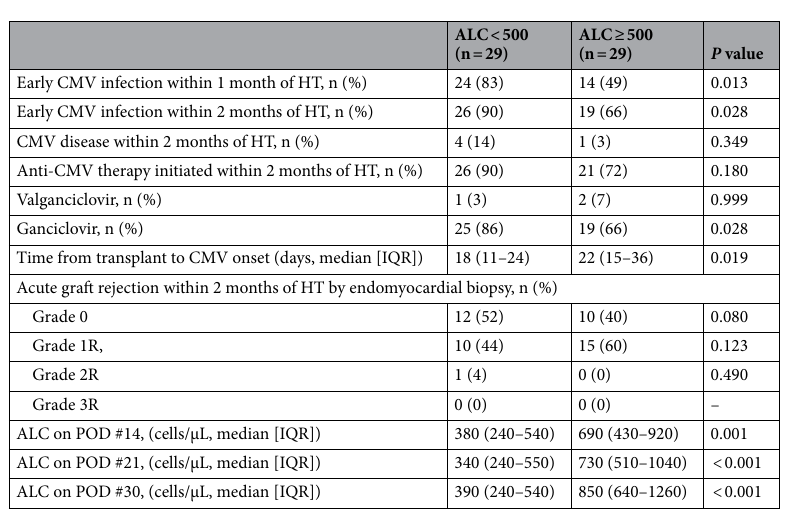
Table 2. Post-transplant outcomes stratified by the ALC on POD #7. Values are expressed in numbers (%) or the median (interquartile range). ALC = absolute lymphocyte count, CMV = cytomegalovirus, HT = heart transplantation, POD = postoperative